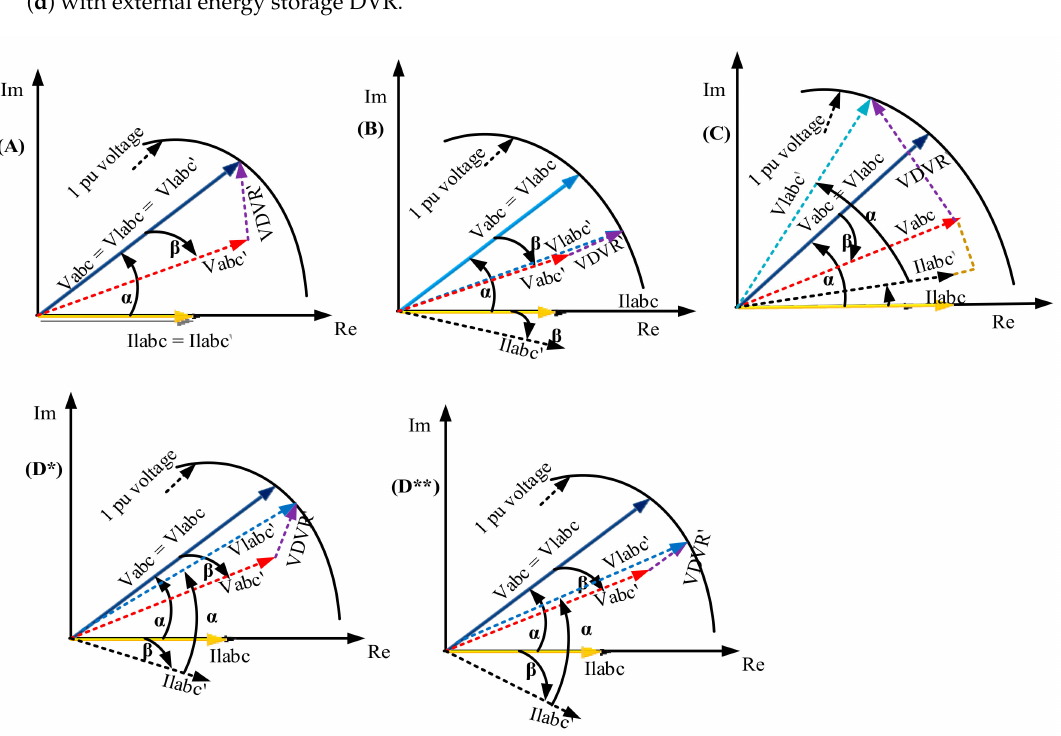
Figure 4. DVR voltage compensation strategies: ( A ) pre-fault; ( B ) in-phase; ( C ) energy optimized; ( D* , D** ) pre-fault and in-phase